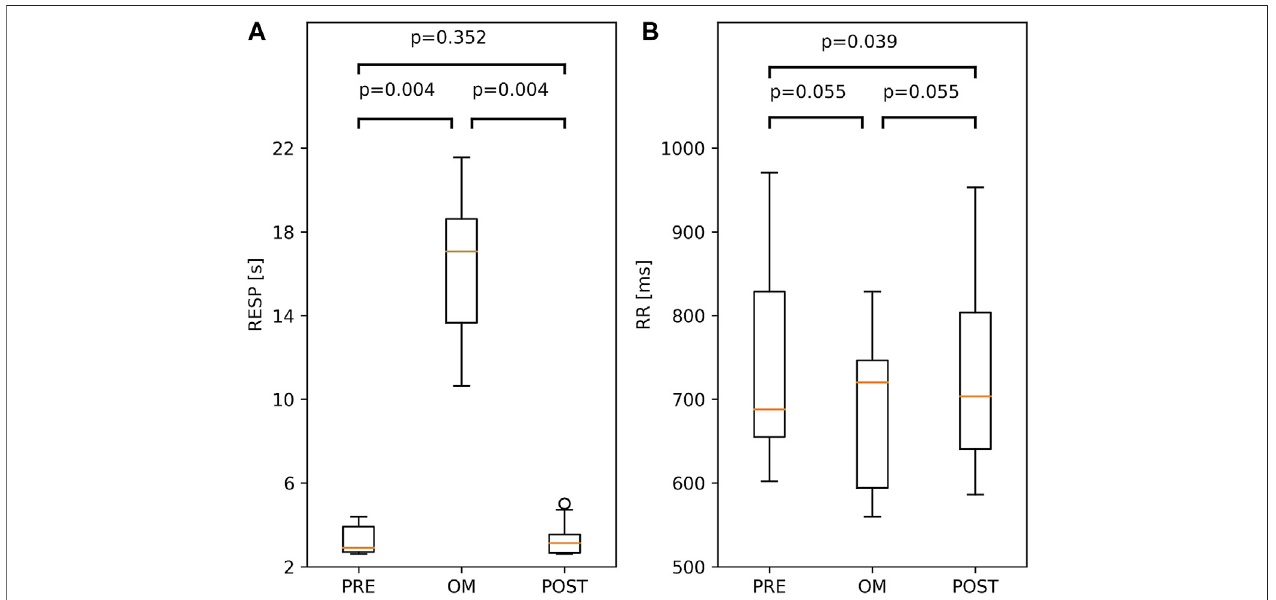
FIGURE 3 | Boxplots of Respiratory period, RESP, (A) and RR interval; RR, (B) during OM, pre-resting and post-resting. The probability of similar values between two conditions is indicated by the p-values above the box and whisker plot. The boxplots show median and quartiles (horizontal lines), and maximum and minimum values (whiskers).